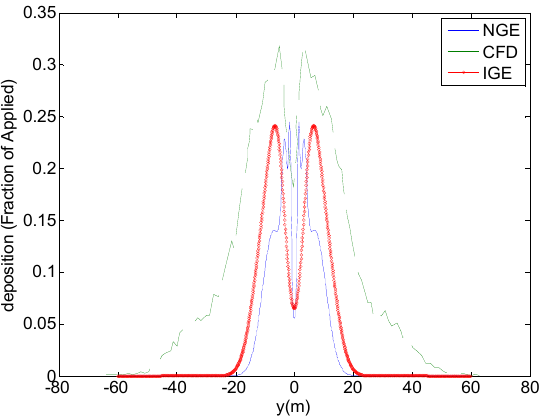
Figure 13. Comparisons of ground depositions in absence of wind predicted by CFD [19], NGE and IGE model proposed in this paper.